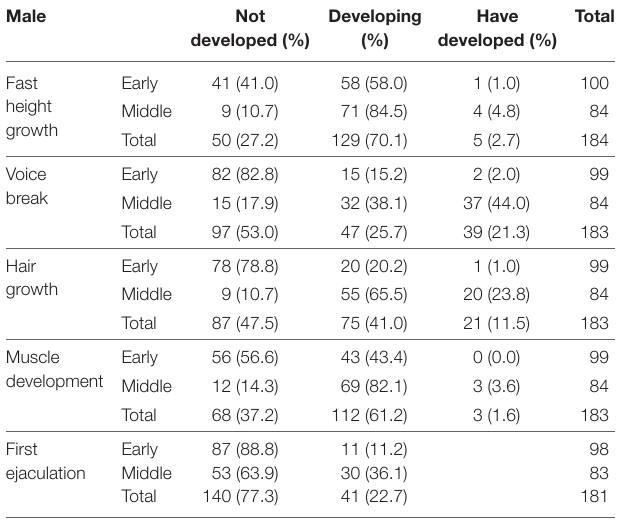
TaBle 3 | The state of development of adolescent physical development in males for each group.